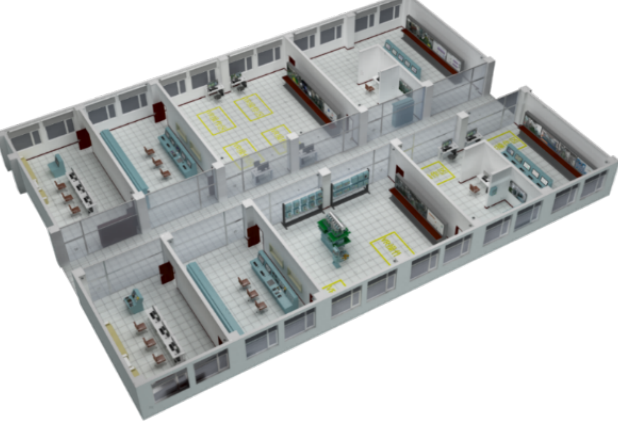
Figure 1. Typical layout of marine engine room simulator.